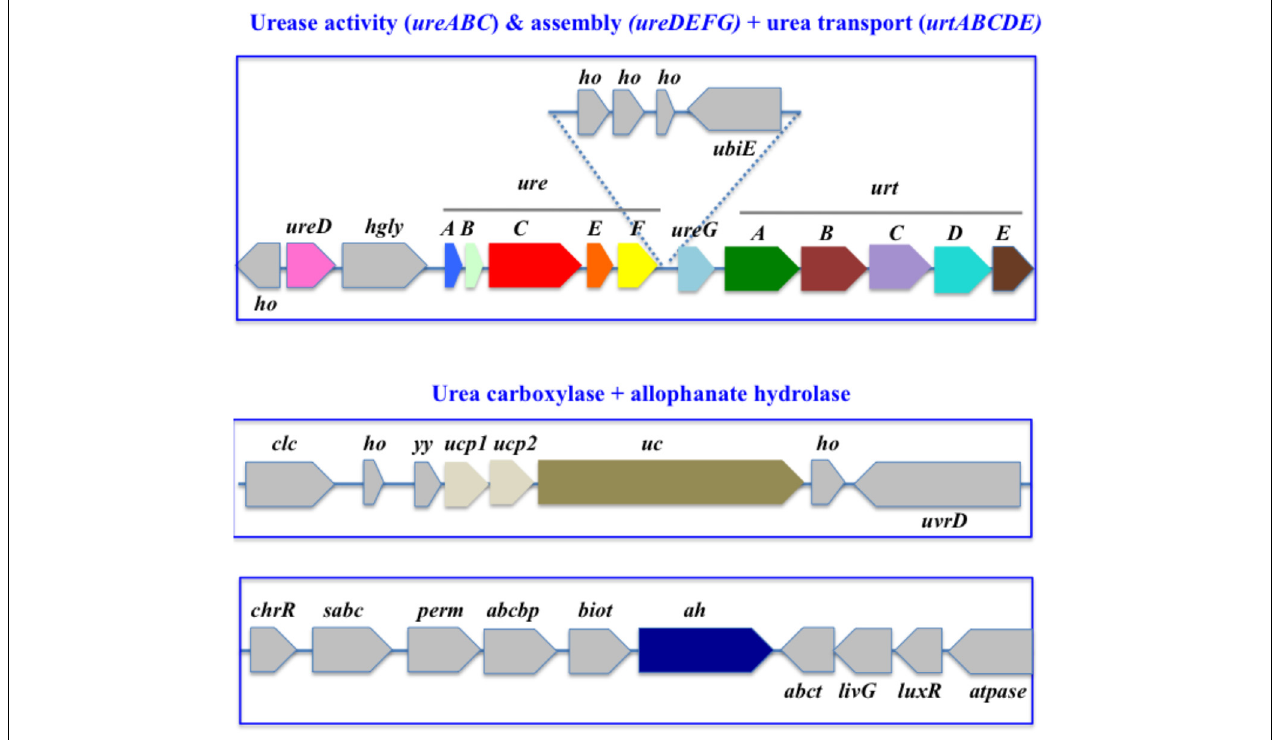
FIGURE 2 | Organization of the urea acquisition and catabolism genes in Cyanothece PCC 7425. The genes are shown as colored boxes pointing in the direction of their transcription. Gray boxes correspond to genes not known to be involved in urea metabolism or transport. abcbp , ABC transporter ATP-binding protein; biot , biotin-[acetyl-CoA-carboxylase] synthetase; chrR , anti-ECF regulator; clc , chloride channel core; ubiE, ubiquinone biosynthesis protein; ho , hypothetical protein; sabc , sulfonate binding ABC transporter protein; ucp1 , urea carboxylase associated protein 1; ucp2 , urea carboxylase associated protein 2; uvrD , DNA helicase; yy , YKKC-YXXD leader in MBGD; perm , ABC transporter permease; abct , amino acid ABC transporter ATPase; livG , leucine/isoleucine/valine transporter ATP-binding subunit; luxR , LuxR family transcriptional regulator; atpase,